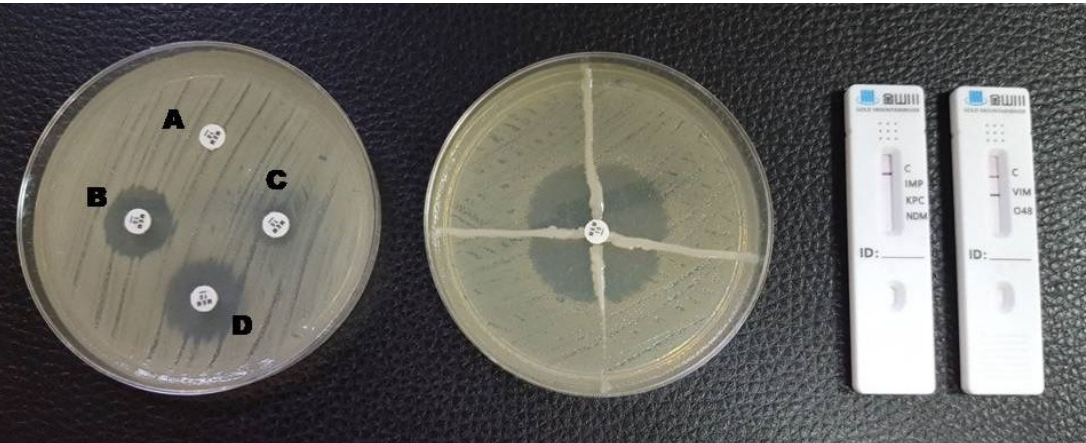
Figure 2. Phenotypic and lateral flow assay results for a VIM-producing K. pneumoniae . A: meropenem disc without inhibitors; B: meropenem + EDTA; C: meropenem + phenylboronic acid; D: meropenem + EDTA + phenylboronic acid. The Hodge test was positive and a red line in the VIM test area is visible in the LFA.